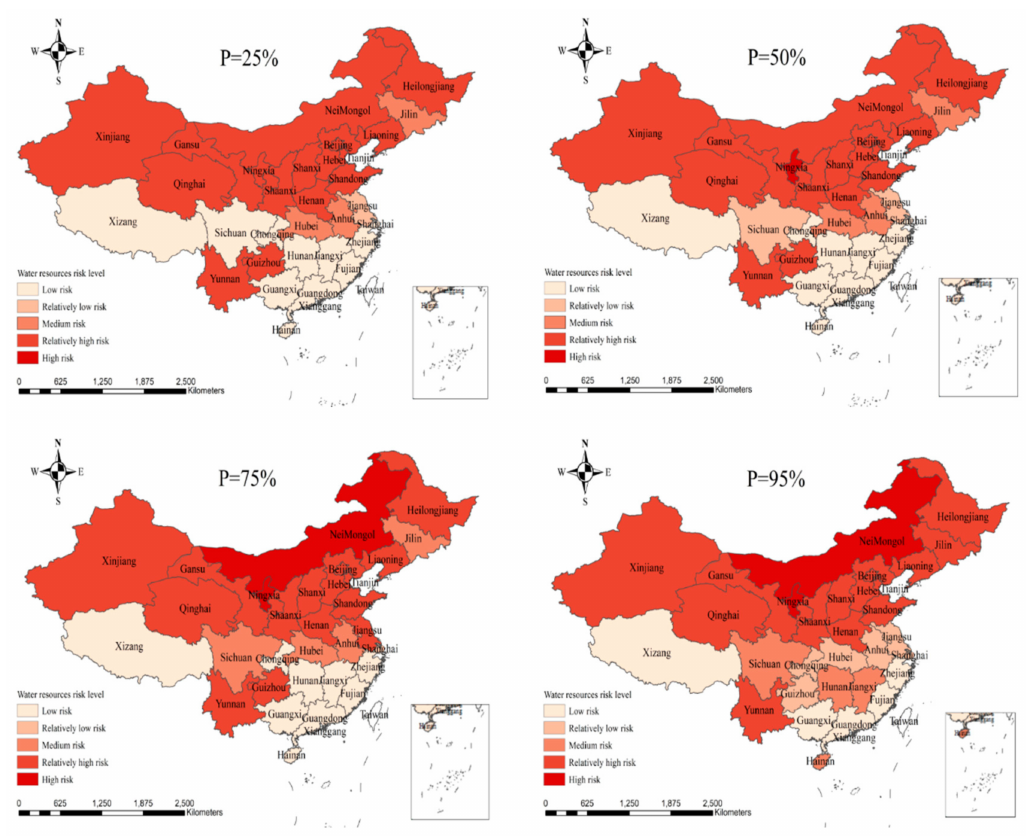
Figure 3. The risk level distribution of water resource shortage with different guarantee rates P in China 2020